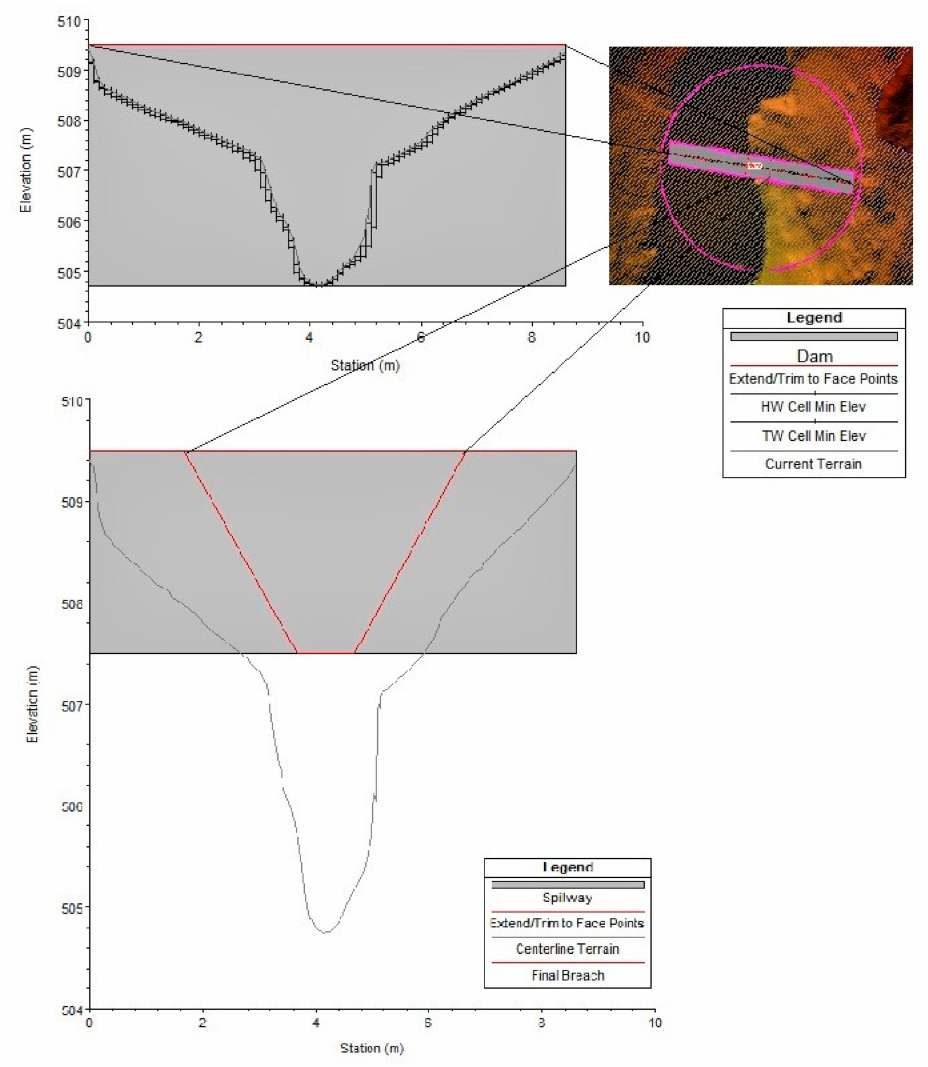
Figure 11. Dam technical characteristics simulation